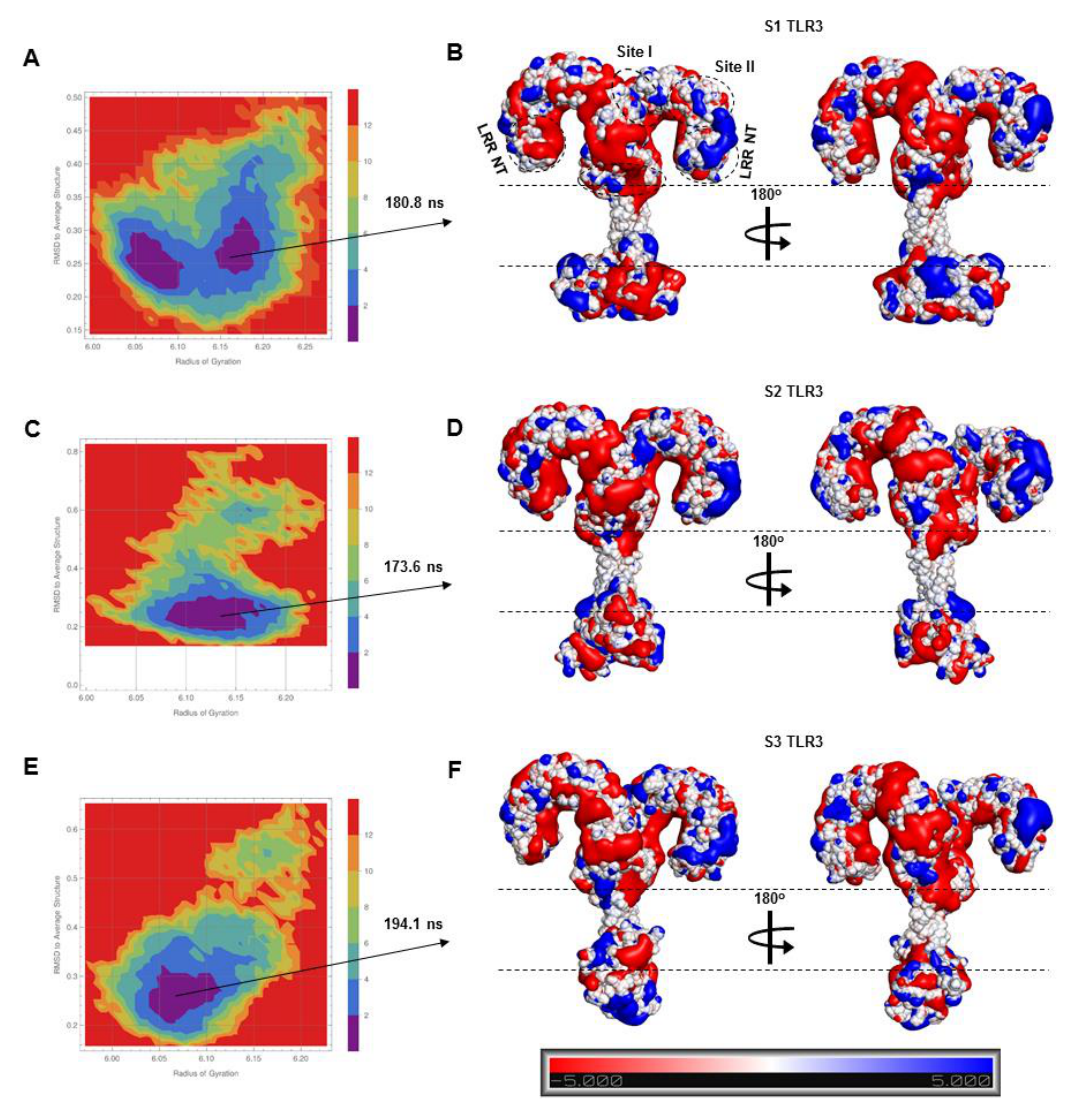
Figure 2. The Gibbs free energy landscape (FEL) and electrostatic properties of TLR3. ( A , C , E ) The FEL of S1, S2, and S3-TLR3 sampled across the molecular dynamics (MD) trajectories of replicate 2. The blue region in the center of the plot indicates the low-energy conformations of the protein. The electrostatic potential surfaces were constructed from a representative conformation extracted from the low-energy structural ensemble of each FEL. ( B , D , F ) The electrostatic potential surface of the TLR3 homodimer. Blue, red, and white colors represent positively charged, negatively charged, and neutral surfaces, respectively. A 180 ◦ view of each model is shown alongside of each panel. Dashed lines indicate the approximated membrane boundary.